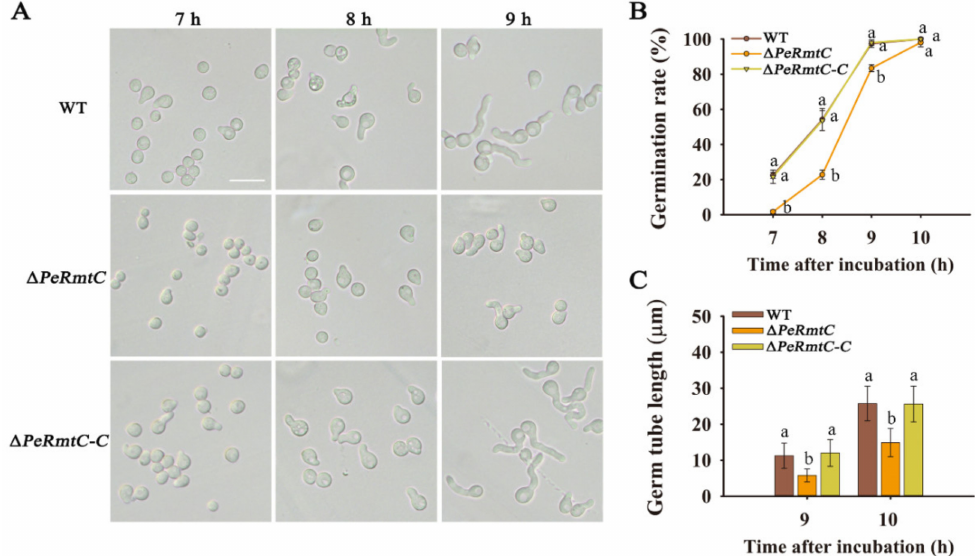
Figure 3. Effects of PeRmtC on conidia germination and germ tube elongation. ( A ) Morphologies of conidia germination among the WT strain, ∆ PeRmtC , and ∆ PeRmtC-C after 7, 8, and 9 h of incubation. The scale bar indicates 20 µ m. ( B ) Conidia germination rate of each strain. ( C ) Germ tube length of each strain. The experiments were performed with three biological replicates. Values marked with different lowercase letters indicate significant differences ( p <